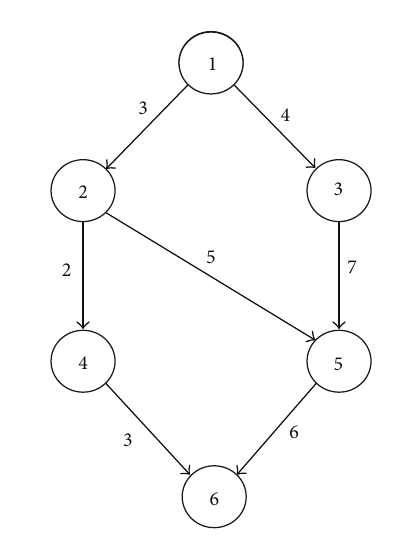
Figure 4: An application DAG with average communication